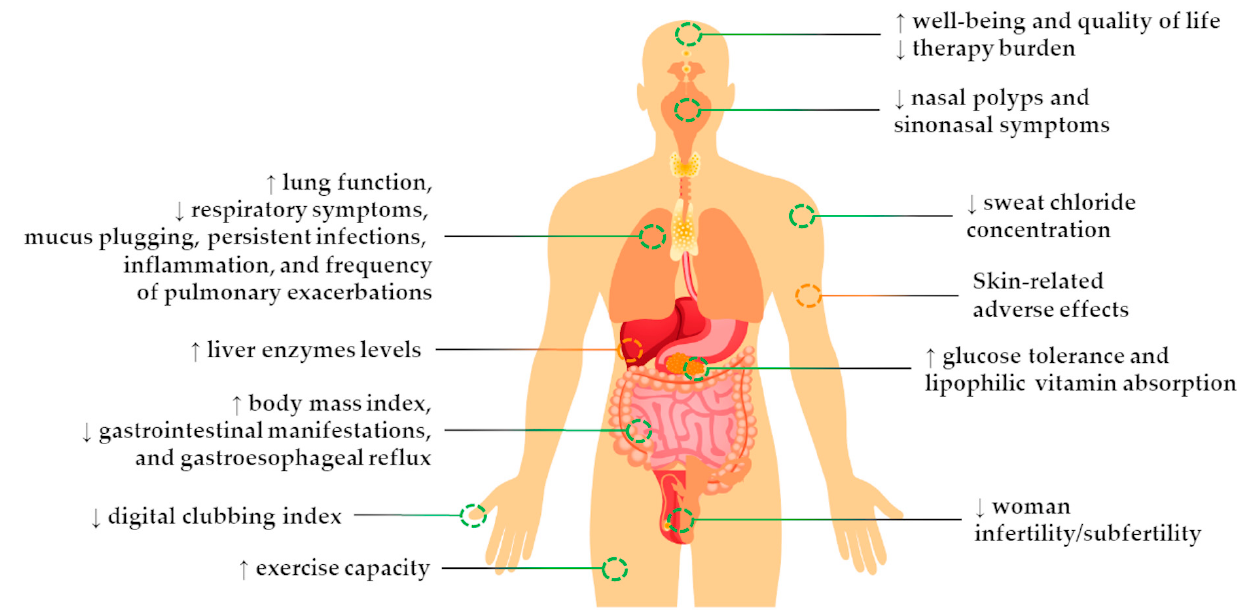
Figure 2. Major clinical effects of elexacaftor–tezacaftor–ivacaftor therapy in people with cystic fi- brosis.